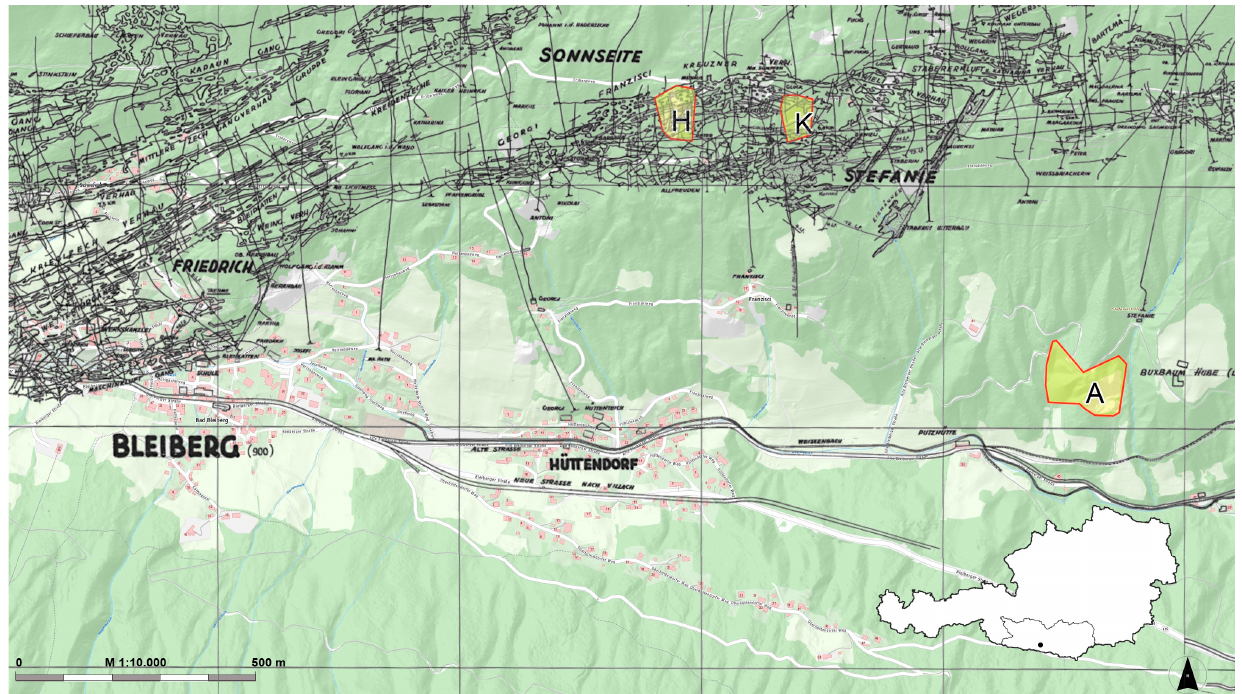
Figure 1. This map segment shows the historical mining map as a black overlay on the current base map. The highlighted areas are the investigated waste dumps (A, H, and K). Overlay created with images from [16,17]. Image from [17] was reproduced with permission from GKB Bergbau GmbH.